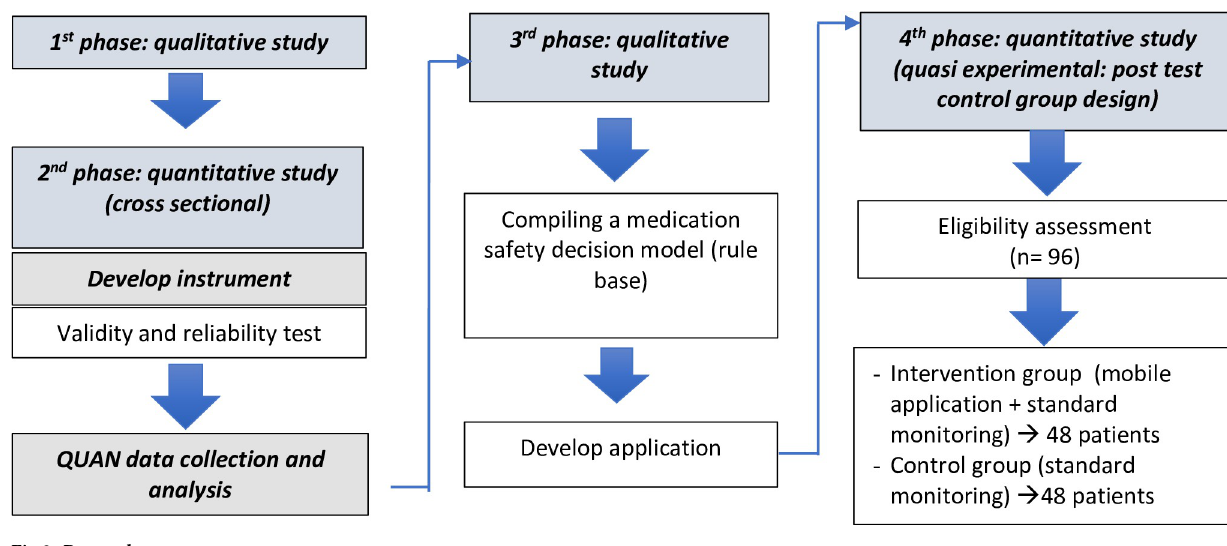
Fig 3. Research stages.